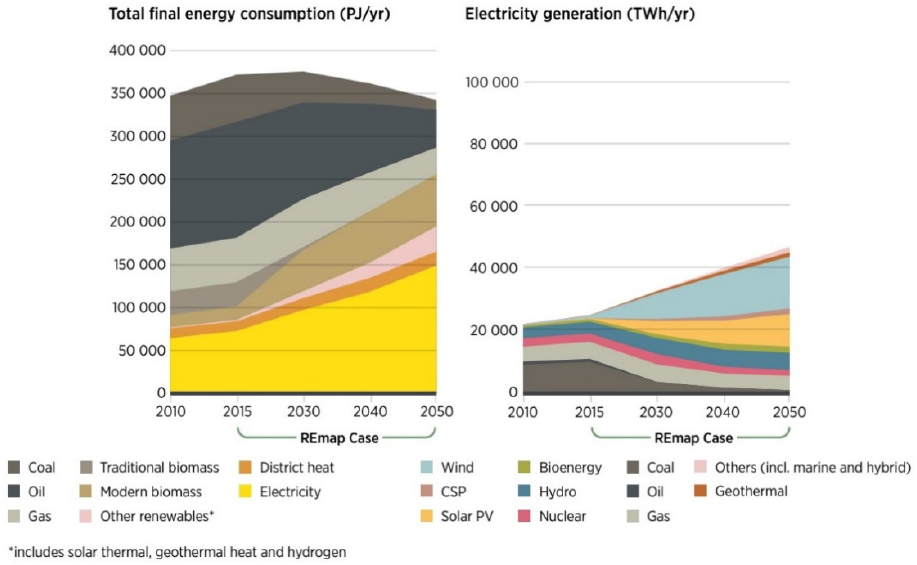
Figure 2. IRENA’s prediction of fossil fuel and renewable energy demand by 2050 [16].